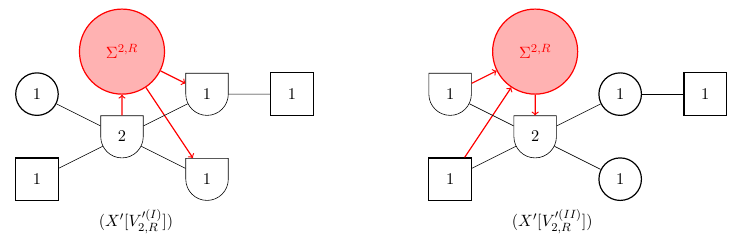
Figure 44 . Two different realizations of a vortex defect as 3d-1d systems in a flavored D 4 quiver. The Witten index for the SQM in the first case should be computed in the chamber ξ < 0 , while for the second case it should be computed in ξ > 0